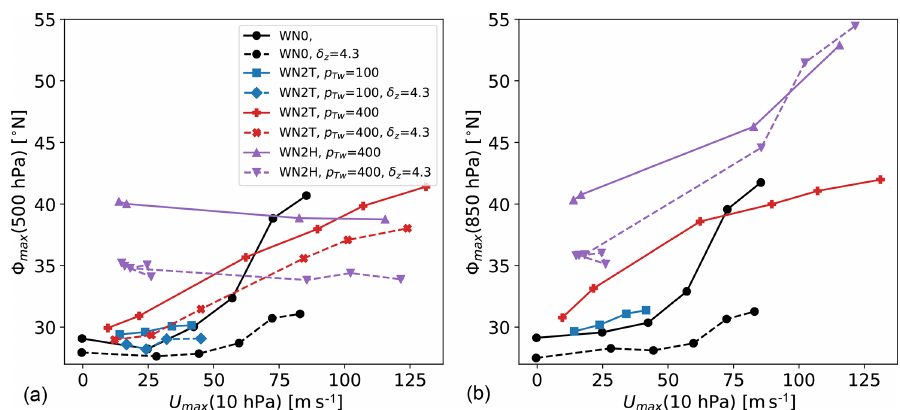
Figure 11. Latitude of the zonal-mean zonal wind maximum at 500hPa (a) and 850hPa (b) displayed against the maximal zonal-mean zonal wind u max at 10hPa for various simulation setups: simulations under the PK setup without topography (labeled WN0), and with WN2 planetary waves forced topographically (labeled WN2T) and diabatically (labeled WN2H) for various values of the winter transition pressure p Tw and tropospheric tropical vertical temperature gradient δ z (see legend; if no value is given, the parameter is set to default). Each symbol displays the value diagnosed from the climatology of simulations with varying polar vortex lapse rate γ . The values for the WN2T simulations with δ z = 4 . 3K are not shown on the right, because data at 850hPa were not saved